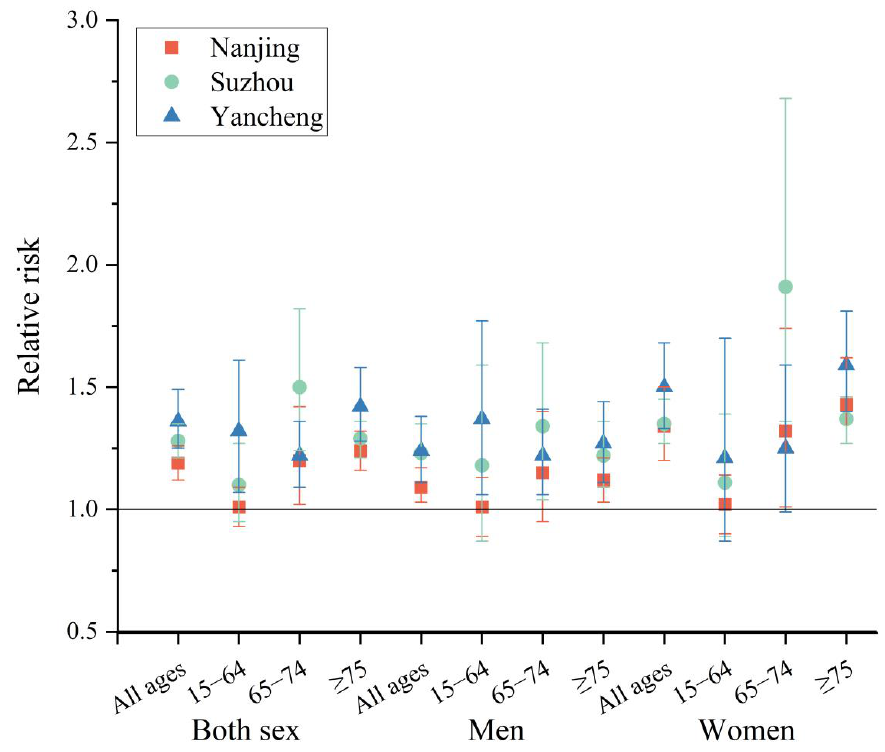
Figure 6. Cardiorespiratory mortality relative risk stratified by sex and